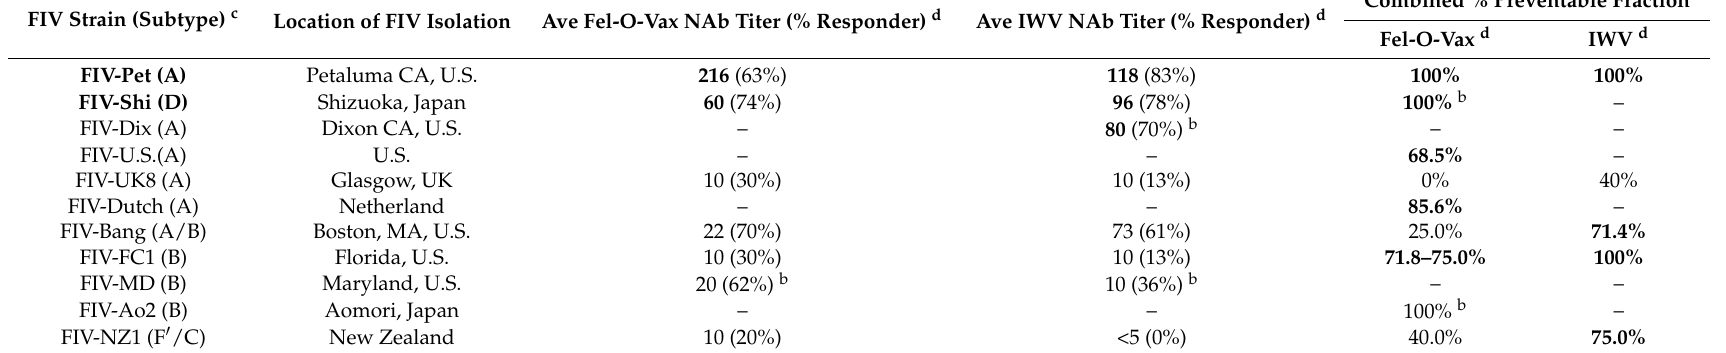
Table 3. Average NAb to vaccine viruses and heterologous subtype-A FIV viruses a,b .